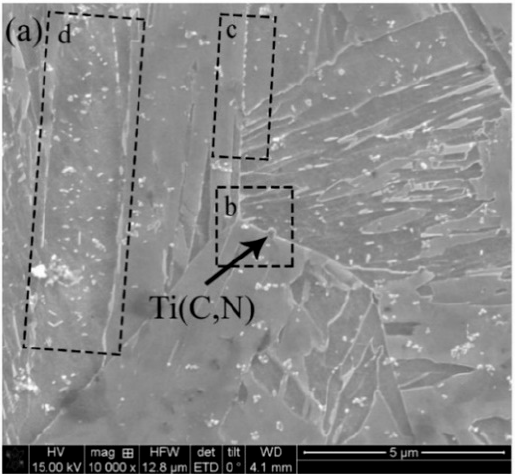
Figure 4. SEM showing ( a ) precipitates with different sizes and shapes: ( b ) Ti (C, N) particle, ( c ) nucleated carbides in the grain boundary, ( d ) transition carbides. Reprinted with permission from ref. [44]. Copyright 2020, MDPI.